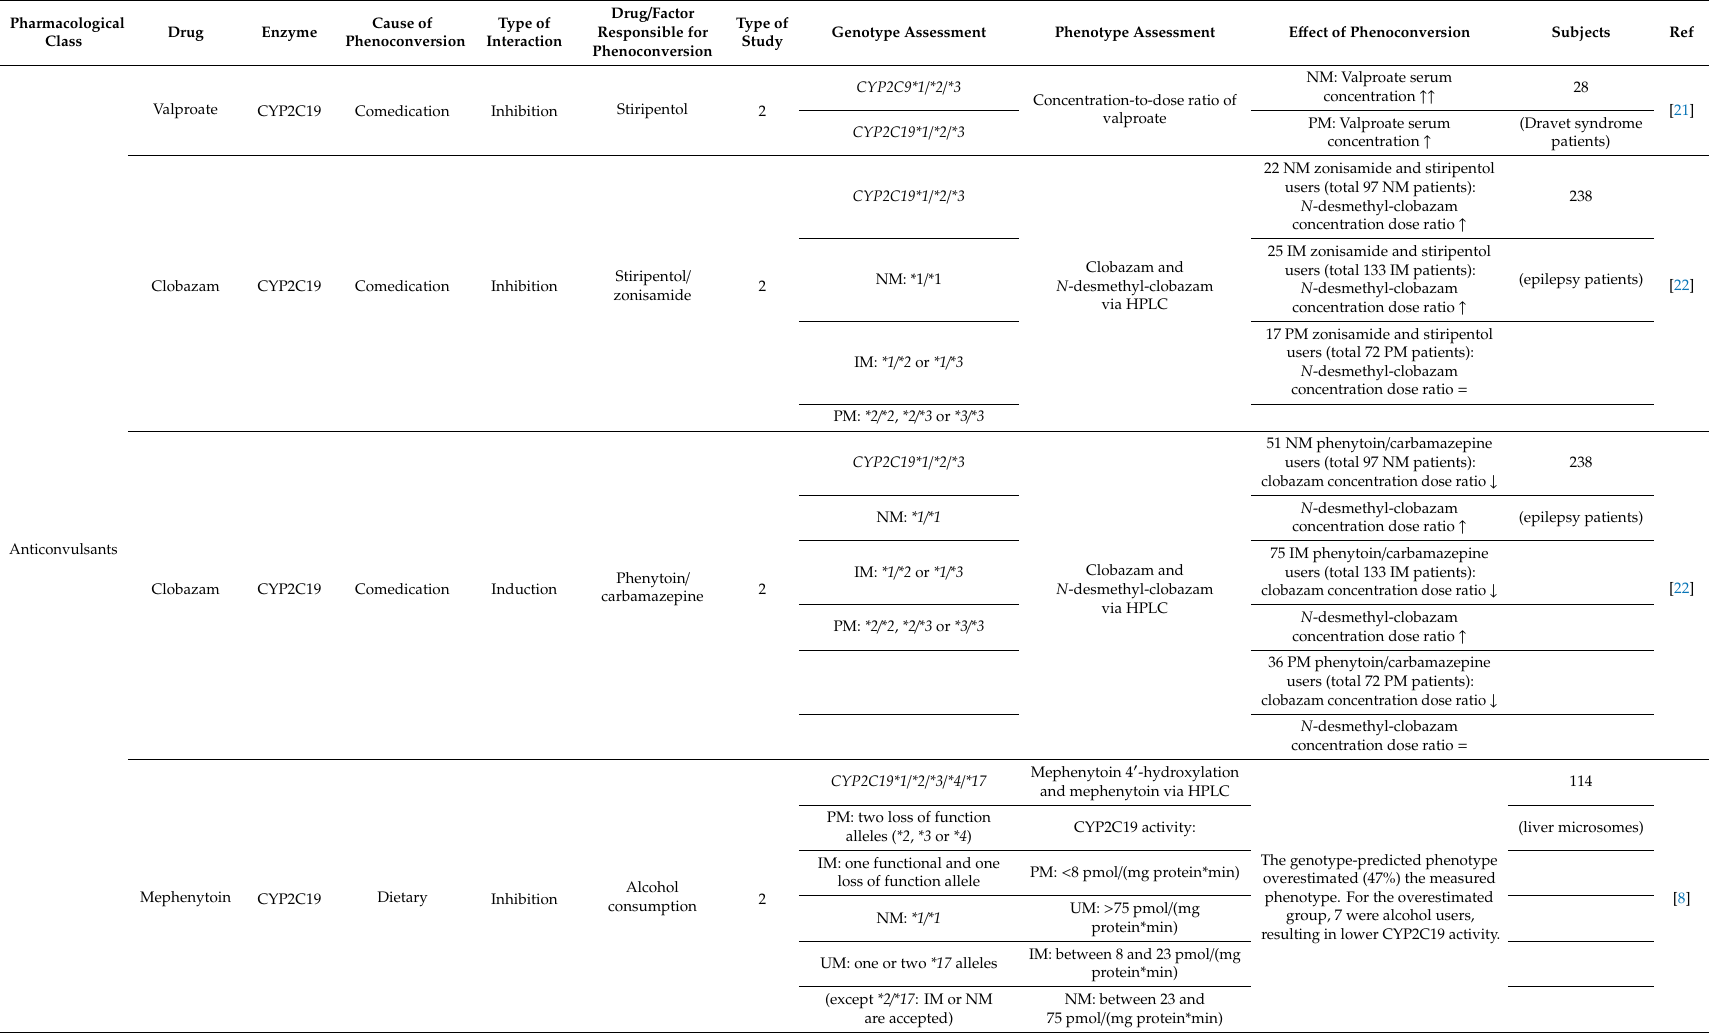
Table 1. The impact of phenoconversion on CYP450 metabolism that results from the use of concomitant drugs and other extrinsic factors. Pharmacological